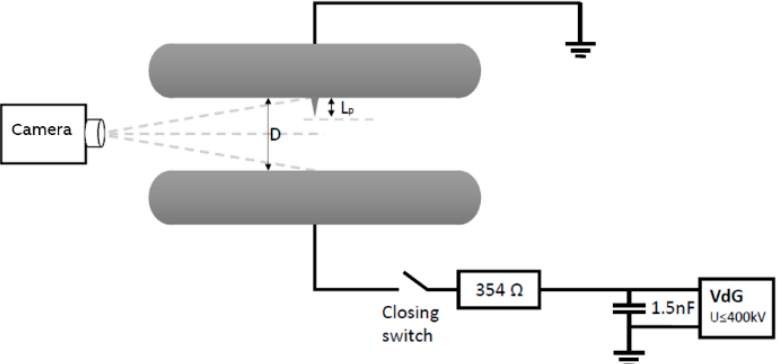
Figure 1. Schematic setup with a single protrusion. The gap length was D = 10 or 15 mm. The load capacitance was charged via a Van de Graaf (VdG) DC source and switched via a resistor and closing switch onto the test gap. The discharges were observed by a high ‐ resolution digital camera (Nikon D9000).